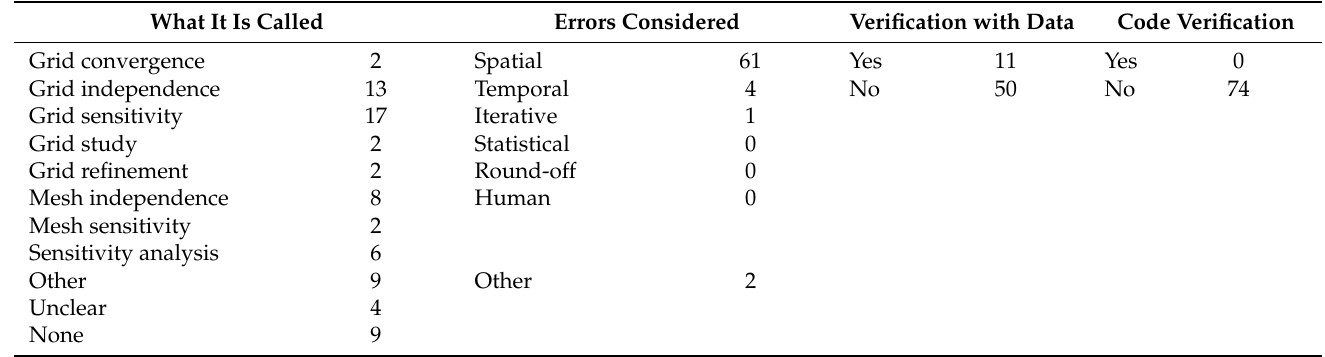
Table 6. Features of verification. The name that different authors give to solution verification is given in the first column, in alphabetical order, except for the “Other”, “Unclear” and “None” categories. Characteristics for all papers that have reported verification (61) are given in the second and third